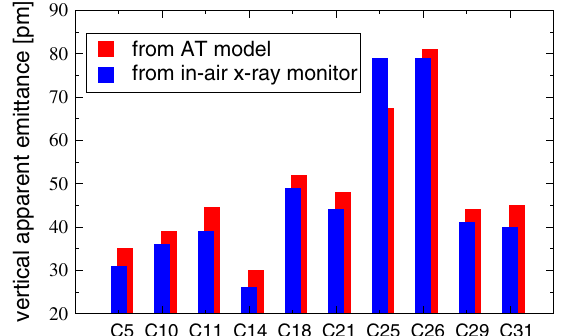
FIG. 3. Example of comparison between the apparent emittan- (before coupling correction) measured at ten available in- ces E y air x-ray detectors (blue) and the predictions of AT (red) after creating the lattice error model from the ORM measurement of January 16,